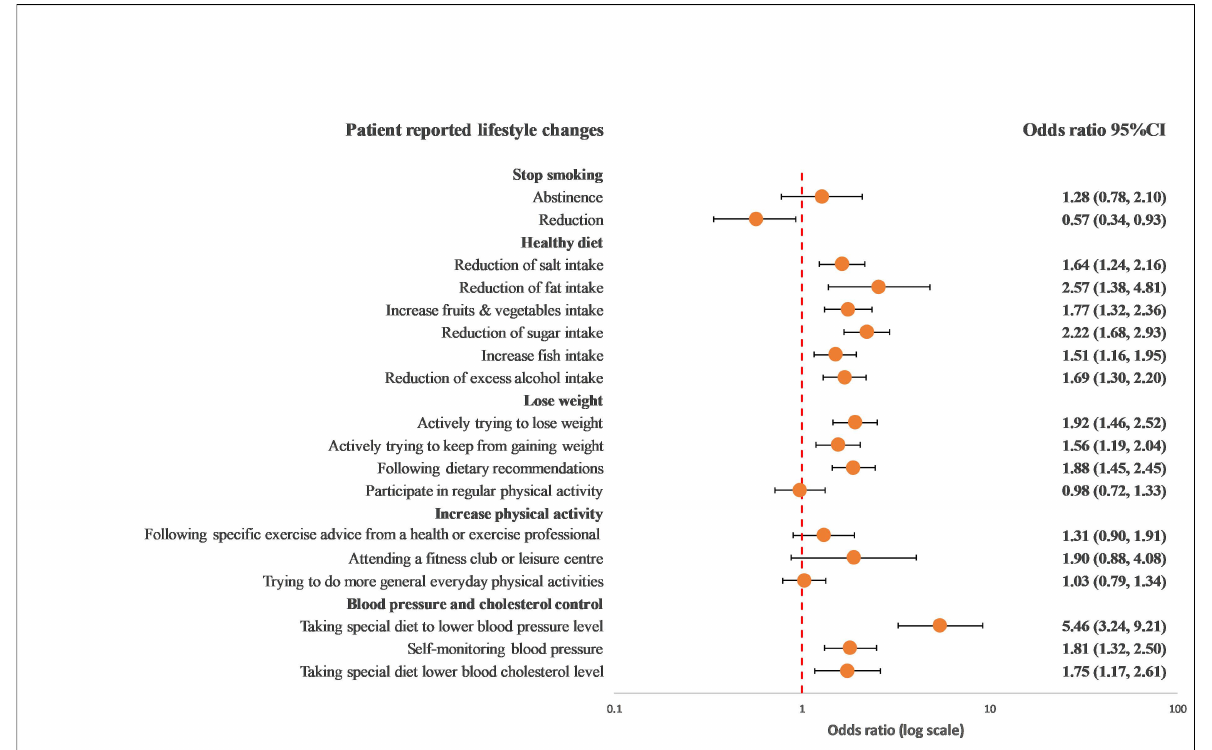
Figure 1. Univariable logistics regression analysis between the recollection of risk factors and patients’ reported lifestyle changes. The model included the recollection of risk factor information (PRRFI = 0 and GRRFI = 1) as the independent variable and patients’ reported lifestyle changes (no = 0 and yes = 1) as the dependent variables. PRRFI: poor recollection of risk factor information; GRRFI: good recollection of risk factor